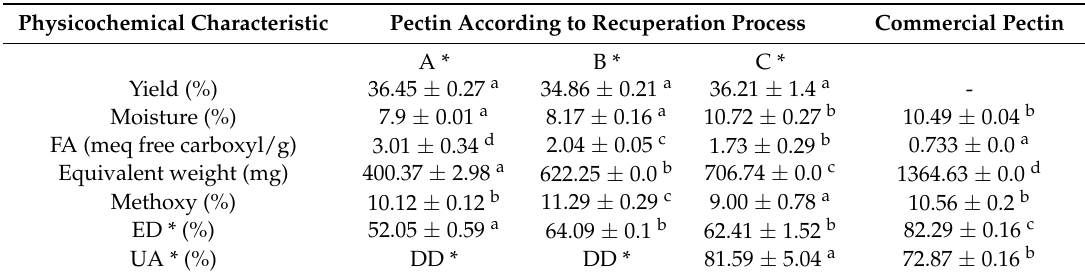
Table 3. Physicochemical characterization of pectins obtained from flour citric waste.